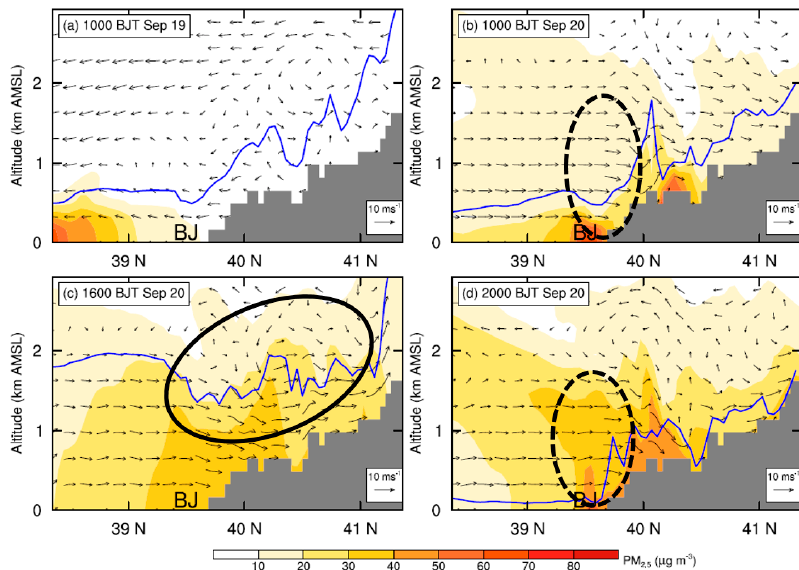
Figure 9. Similar to Figure 7, but for the vertical cross sections of simulated PM 2.5 concentration at ( a ) 10:00 h BJT on 19 September, and ( b – d ) 10:00, 1600, and 20:00 h BJT on 20 September, overlaid with the wind vector fields.